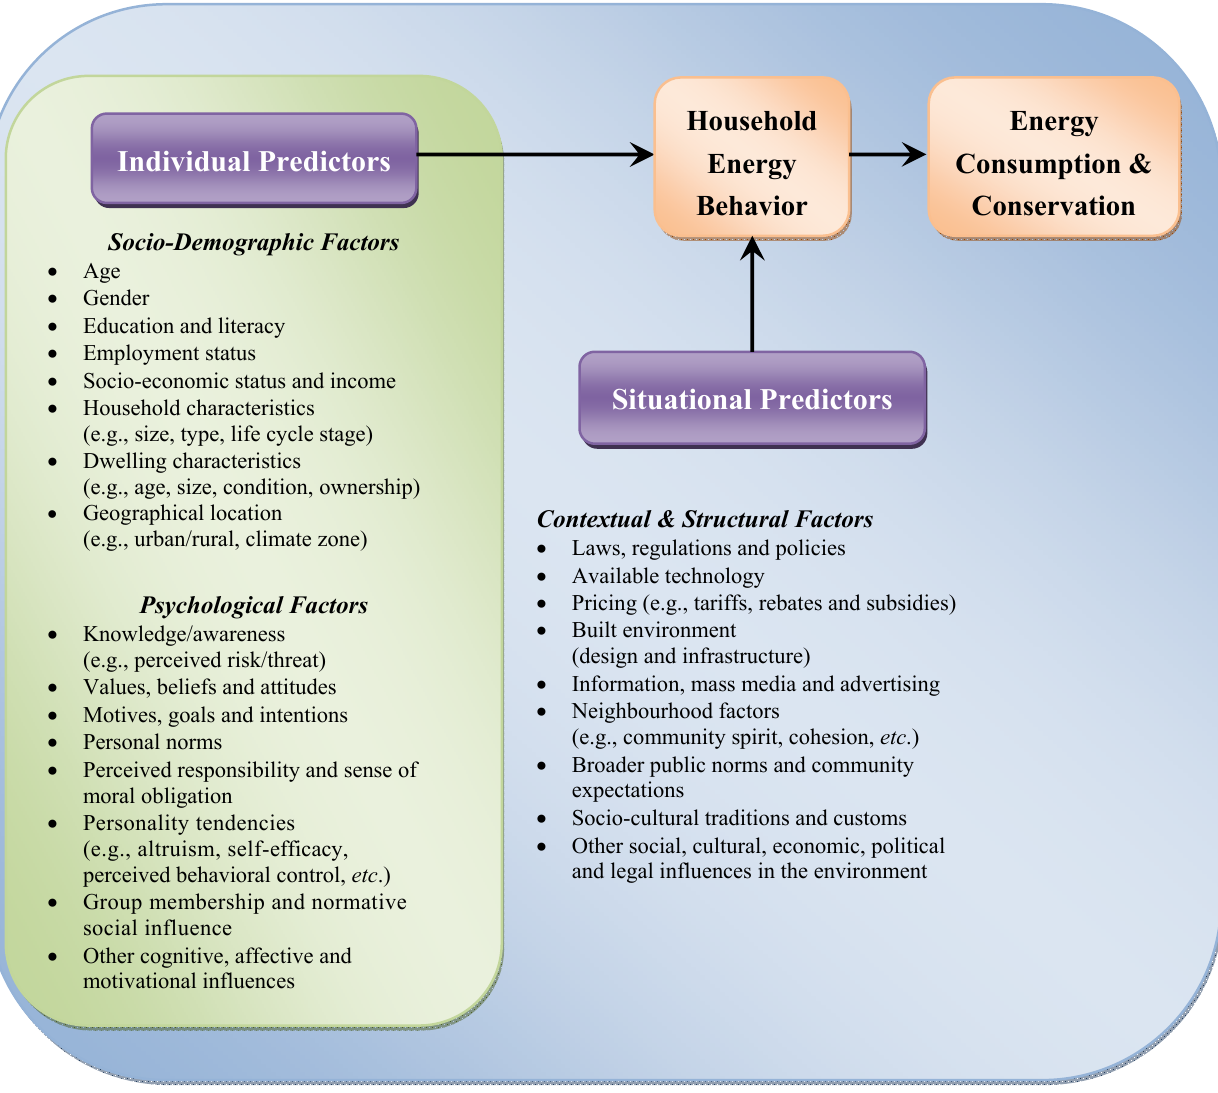
Figure 1. Integrative conceptualization of the various individual (socio-demographic and psychological) and situational (contextual and structural) factors that may influence household energy consumption and